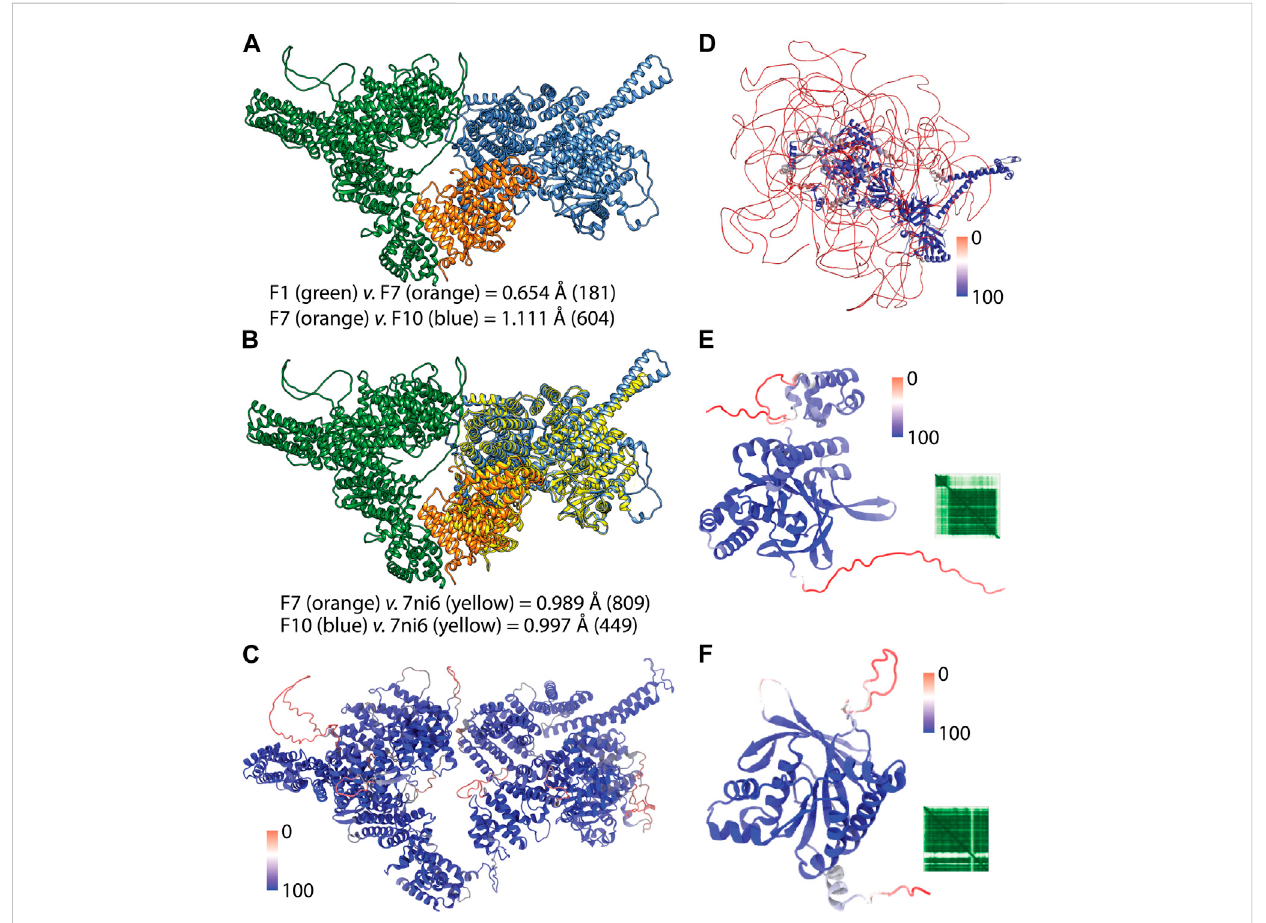
AF2predictionsofthefull-lengthstructures. (A) showsthepairwisesuperimpositionoftheoverlappedAF2predictions.RMSDchangeintheCatrace were shown and the paired number of atoms were given in parenthesis. (B) shows the superimposition of the crystal structure of the C-terminus of ATM (PDB ID: 7ni6). (C) shows the full-length structure of ATM colored according to the con fi dence score pLDDT. (D) shows the full-length structure of BRCA2colored basedoncon fi denceoftheprediction. (E) and (F) show theAF2 structures ofRAD51CandXRCC2 respectively coloredaccordingto per-residue con fi dence scores (pLDDT) (Jumper et al., 2021). Heatmap insets show the predicted aligned error (PAE) of the predictions which shows positional error of each residue pair (Mariani et al., 2013; Jumper et al.,